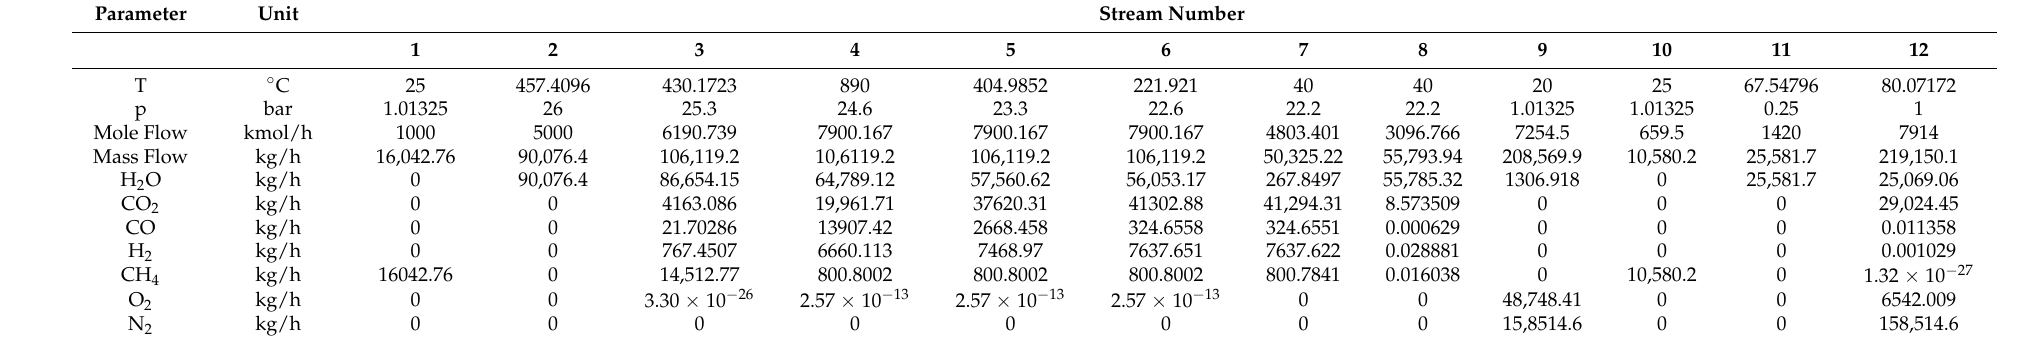
Table A1. Mass/mole flows in SMR process with temperature and pressure state.